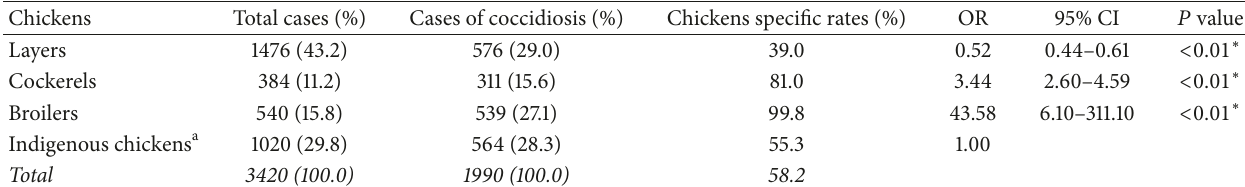
a Reference category. ∗ Significant . OR = odds ratio; CI = confidence interval. Table 5: Chickens distribution of avian coccidiosis in Osun State, Nigeria